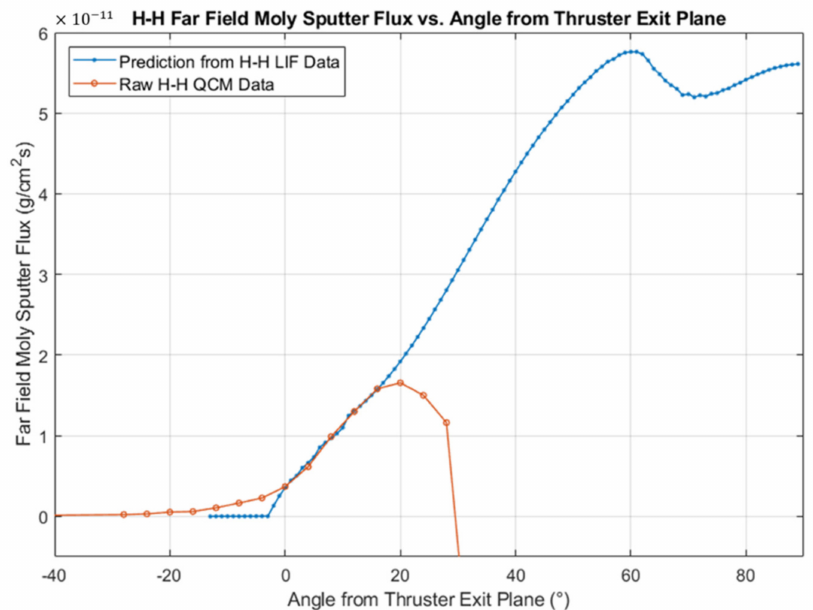
Figure 15. Sputter flux profile along 1-m arc for DTL28-H-H operating condition, based on near-field LIF measurement correlated with QCM data for absolute flux determination.